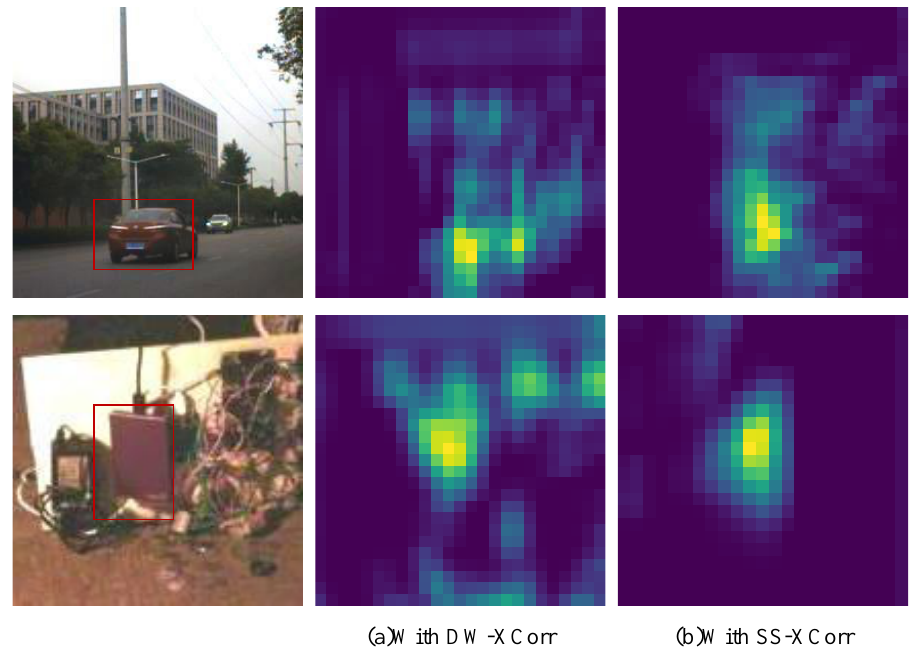
Figure 5. Visualization results of the similarity matrix using the ( a ) DW-XCorr module and the ( b ) SS-XCorr